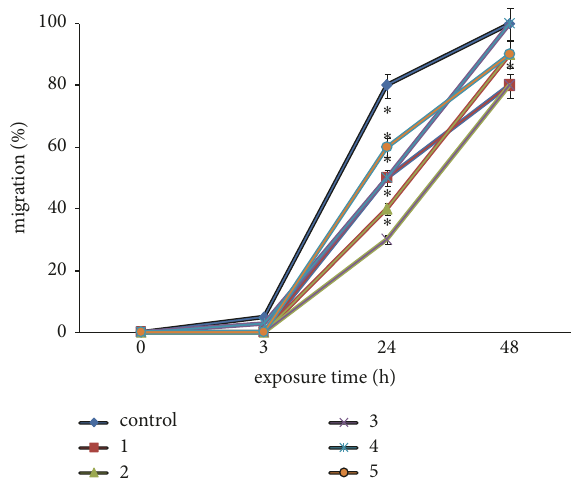
Figure 5: In vitro scratch assay with use of ADSCs for migration rate dynamics study in growth media with different deuterium content. Deuterium concentration: control: D/H 150 ppm; No. 1: D/H 500.000 ppm; No. 2: D/H 100.000 ppm; No. 3: D/H 10.000 ppm; No. 4: D/H 75 ppm; No. 5: D/H 15 ppm. The results are expressed as mean ± SD (n=6); ∗ : significant differences between the experimental group and the control, p <